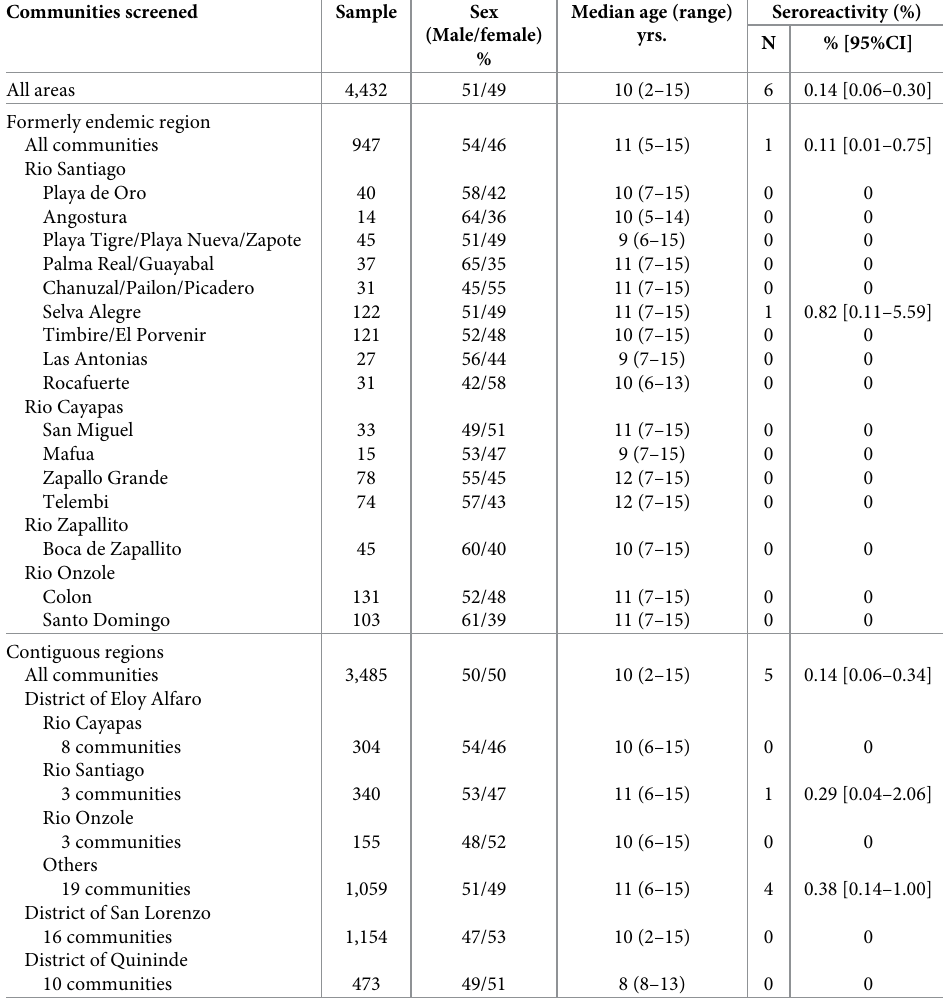
� Endemicity defined by presence of active yaws lesions in 1988 survey